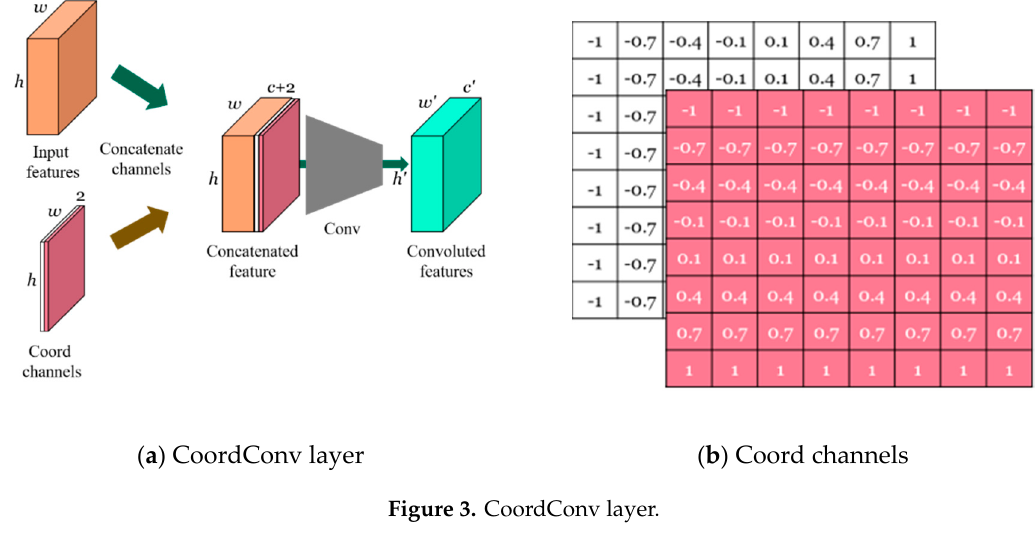
Figure 4. Facial symmetry.